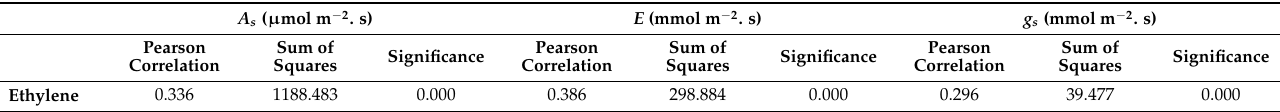
Table 2. Pearson correlations between net CO 2 assimilation ( A s ; µ mol m − 2 . s), transpiration ( E ; mmol m − 2 . s), stomatal conductance ( g s ; mmol m − 2 . s) and ethylene as affected by exposure to